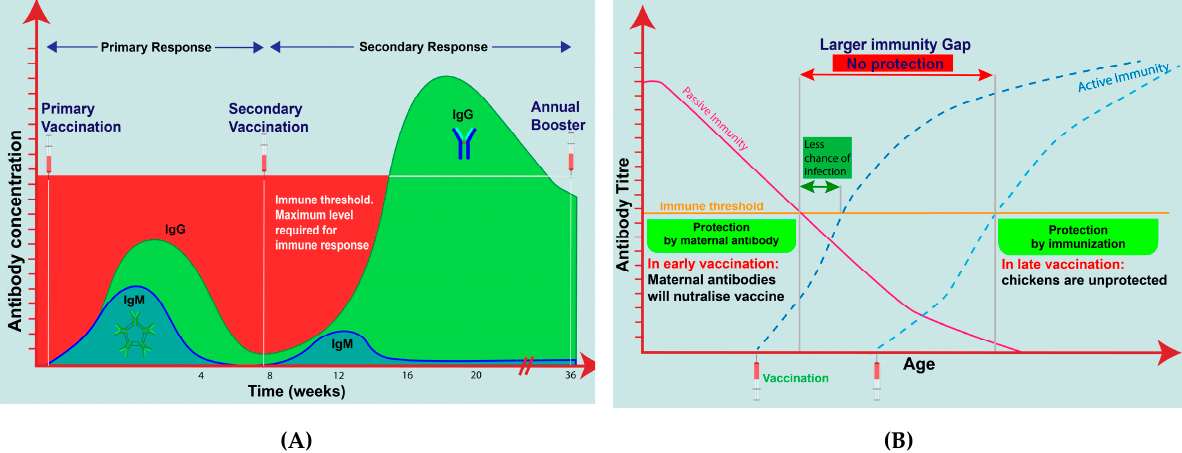
Figure 5. ( A ) Activity of primary and secondary immune response correlated to chicken vaccination with maintaining maximal level of immune response in full cycle of laying birds by using repeated annual boosting during decline of active immunity (https://microbiologynotes.com/differences-between-primary-and-secondary-immune-response/); ( B ) Assess- ment of immunity gap or no protection period between decline of passive immunity and start of active or acquired immunity causing birds to be unprotected and challenged, as active immunization is given protection in immunity gap (https://www.